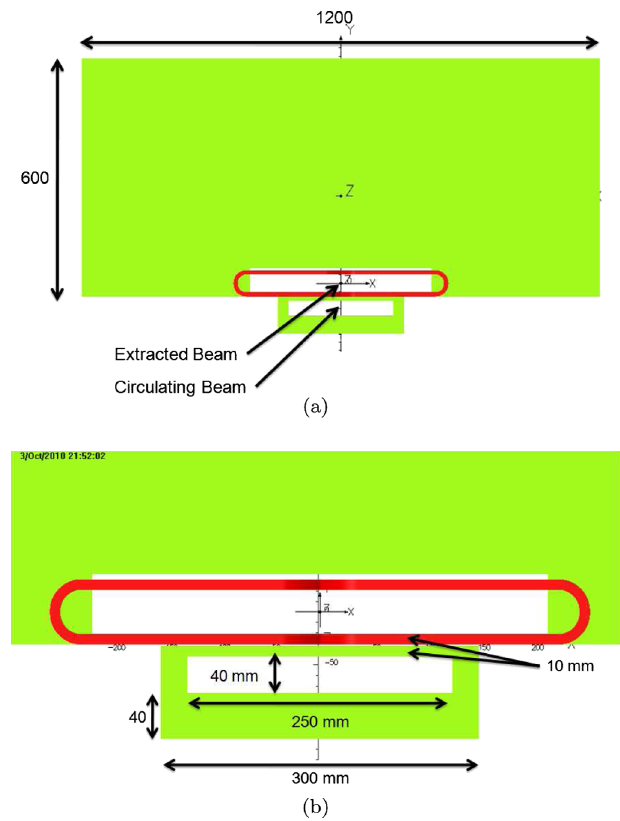
bore.FIG. 42. Front views of the extraction septum for the carbon ring (a) whole septum (b)